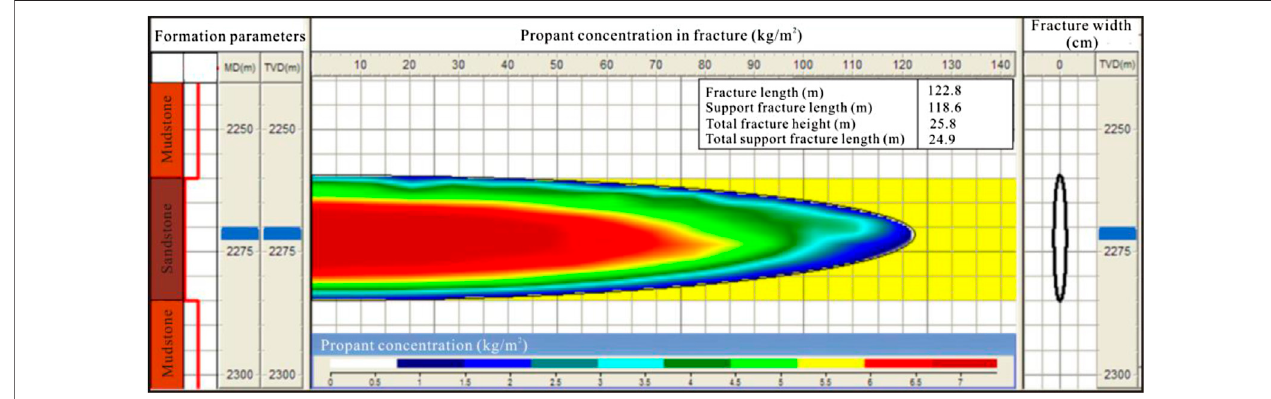
FIGURE 9 | Fracture morphology of the fi rst fracturing segment in the target zone of Well X1.